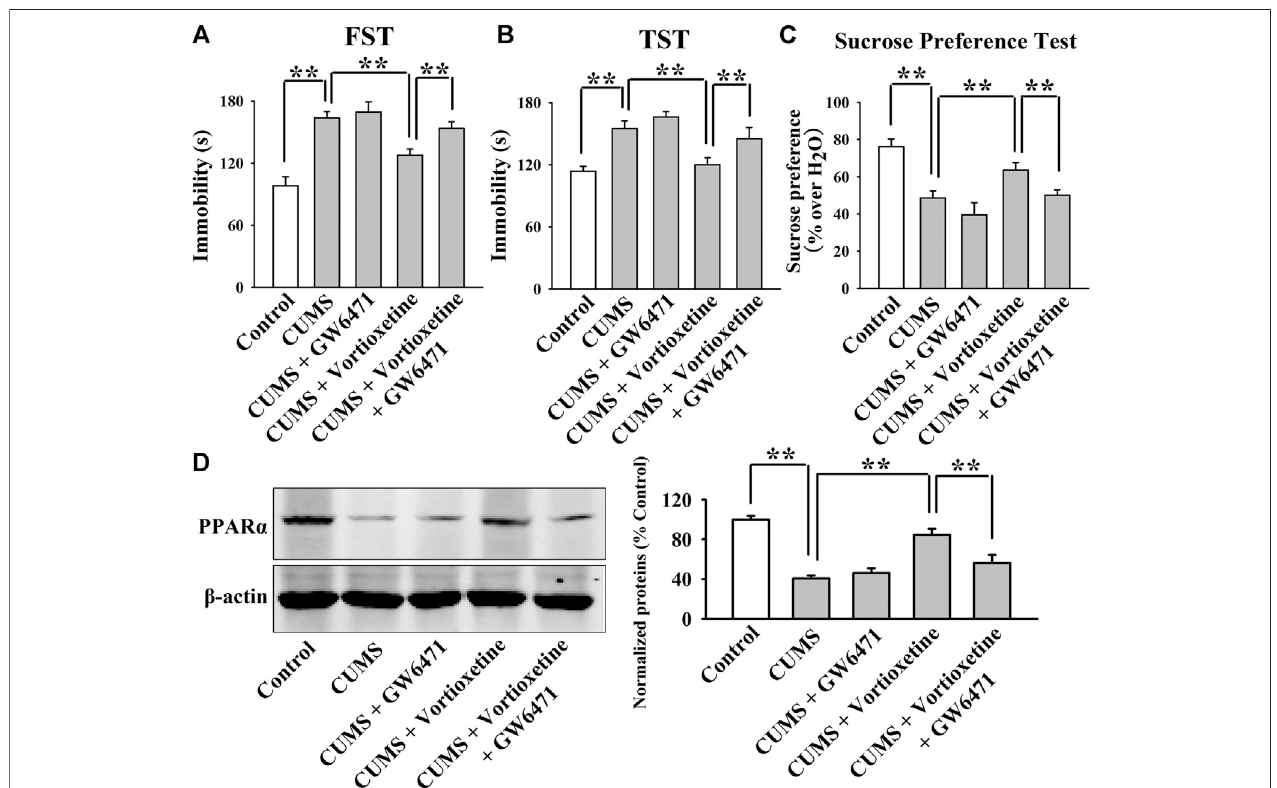
FIGURE 3 | The antidepressant actions of vortioxetine in the CUMS model were fully blocked by GW6471 co-administration. (A – C) The reversal effects of vortioxetine on the CUMS-induced depressive-like behaviors in mice were fully blocked by GW6471 co-administration, as revealed by the FST, TST and sucrose preference test. (D) Representative images and quantitative analyses indicate that the use of GW6471 notably prevented the promoting effects of vortioxetine on the hippocampalPPAR α expressionintheCUMS-exposedmice.For (A – C) , n (cid:2) 10pergroup;For(D), n (cid:2) 5pergroup.Thedataareexpressedasthemeans ± S.E.M.; ** p < 0.01. The comparisons were made by two-way ANOVA followed by Bonferroni ’ s test.